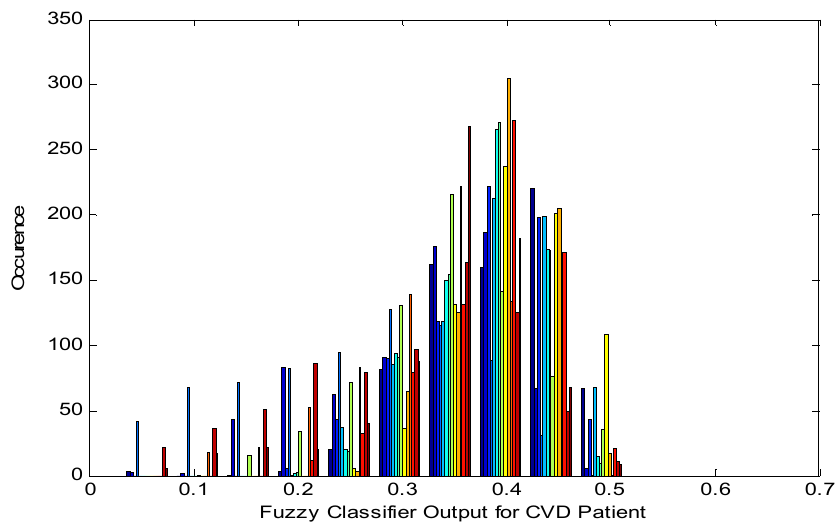
Figure 2. Histogram of fuzzy modeled output.